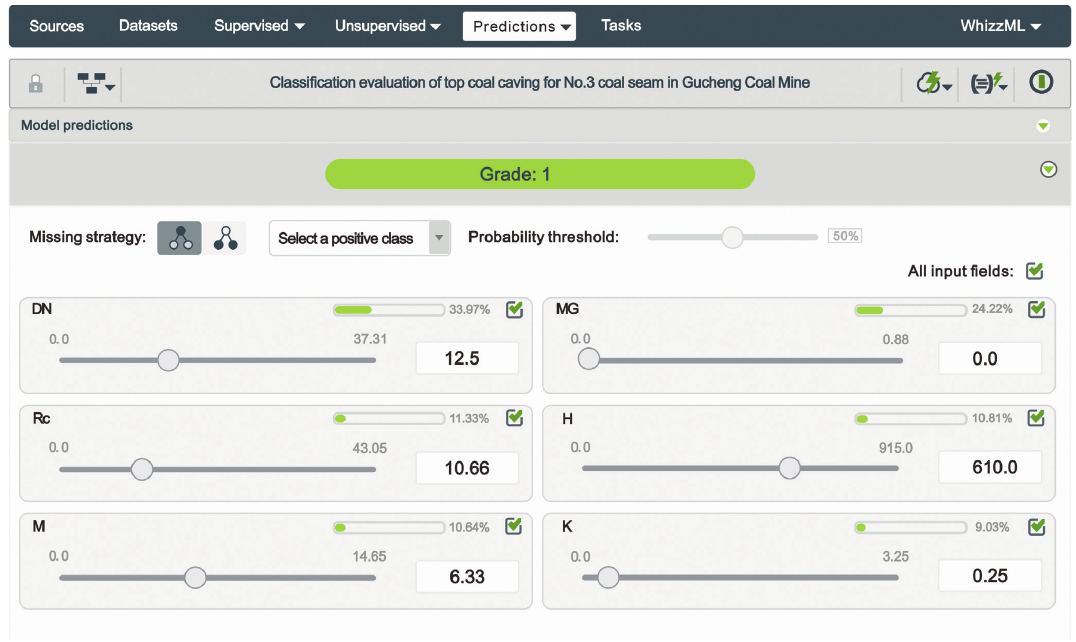
Figure 23: Top coal caving prediction results of No. 3 coal seam in Gucheng Coal